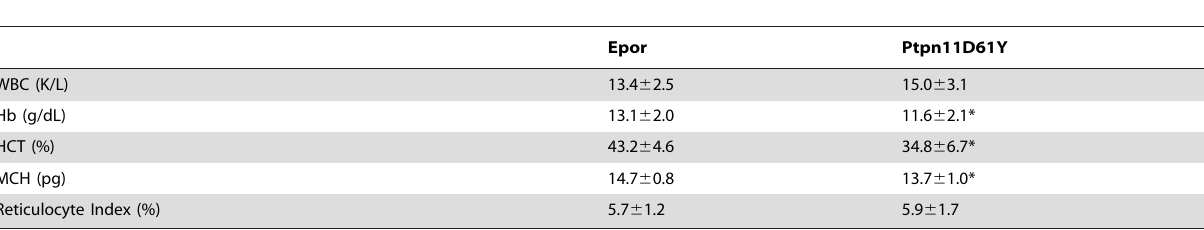
Table 1. Hematologic parameters in peripheral blood of Ptpn11 D61Y mice.